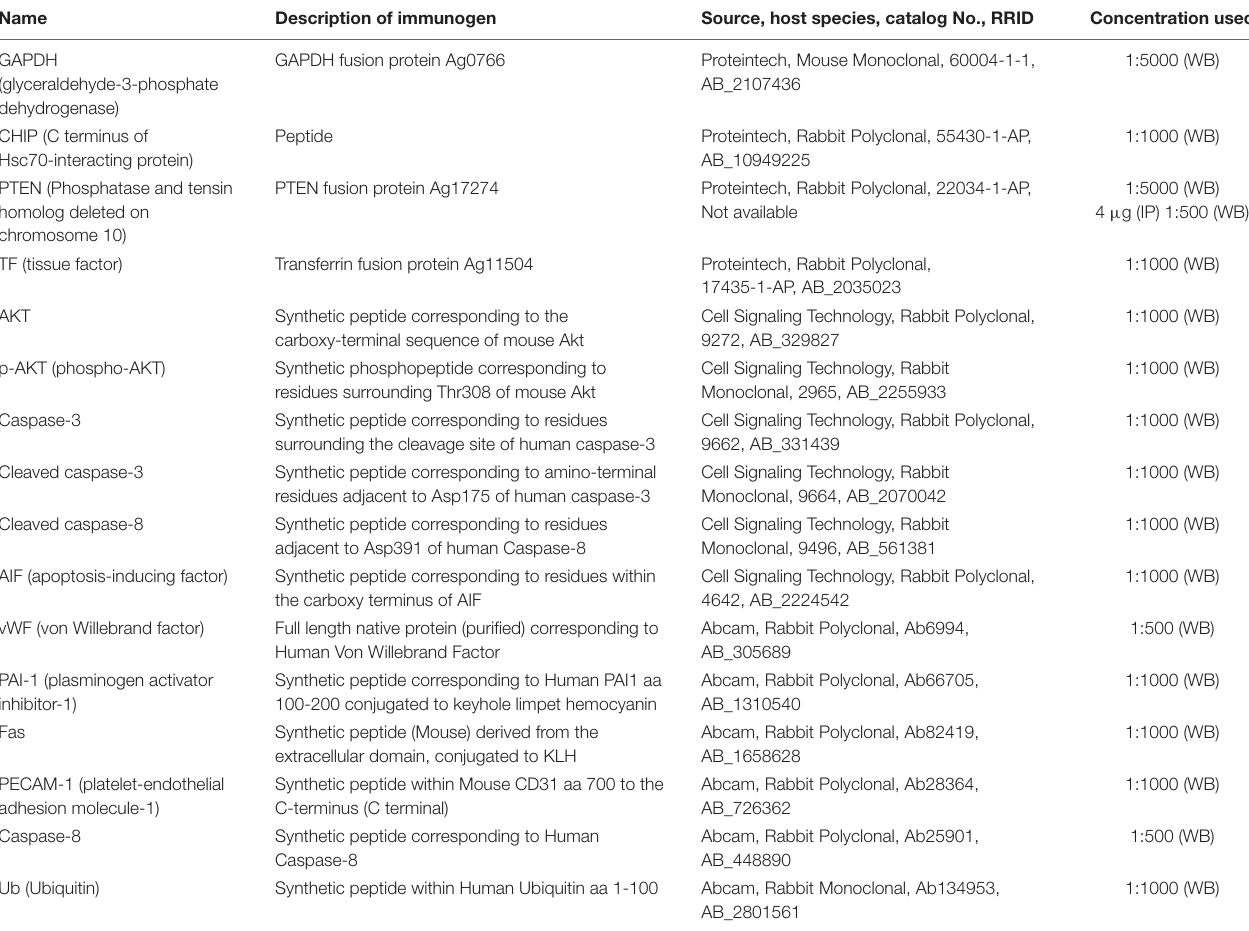
TABLE 2 | Primary antibodies